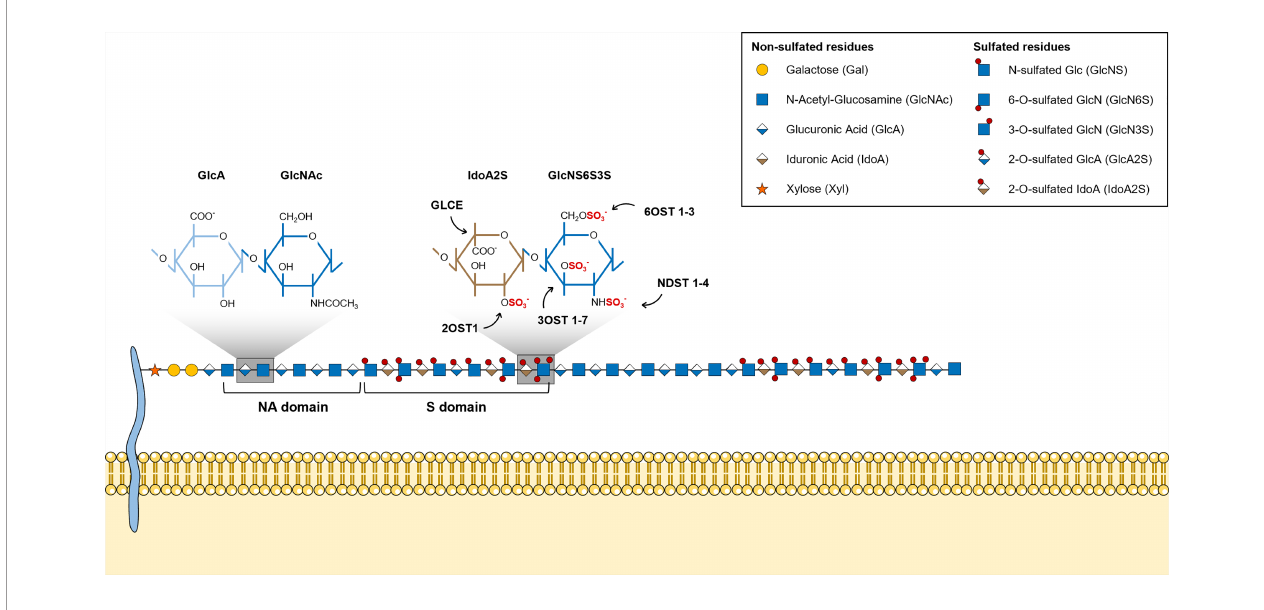
FIGURE 2 | Illustrative representation of a mature HS chain and its structural organization. In mature HS chains, HS disaccharides are organized in two main structural domains: sulfated (S)-domains, enriched in highly modi fi ed disaccharides, and N -acetylated (NA)-domains, that are mostly composed by non-modi fi ed GlcNAc units linked predominantly to GlcA residues. Glycan structures are represented according to the Symbol Nomenclature for Glycans (SNFG)